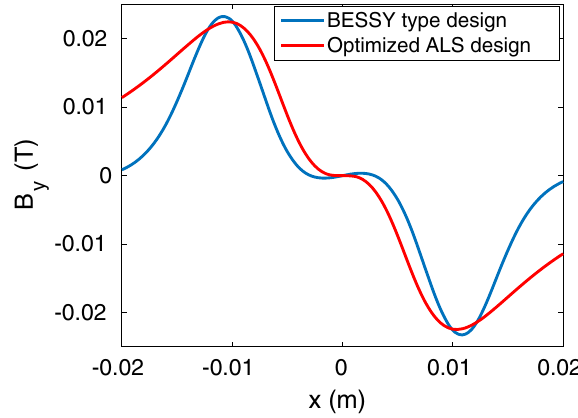
FIG. 4. Vertical magnetic field profiles of NLKs for the BESSY type design and an optimized ALS